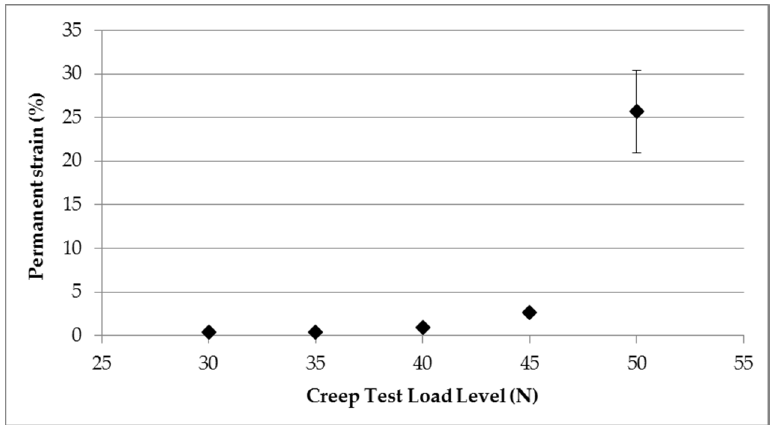
Figure 10. Permanent strain following removal of load after 1 h held at specified load level.